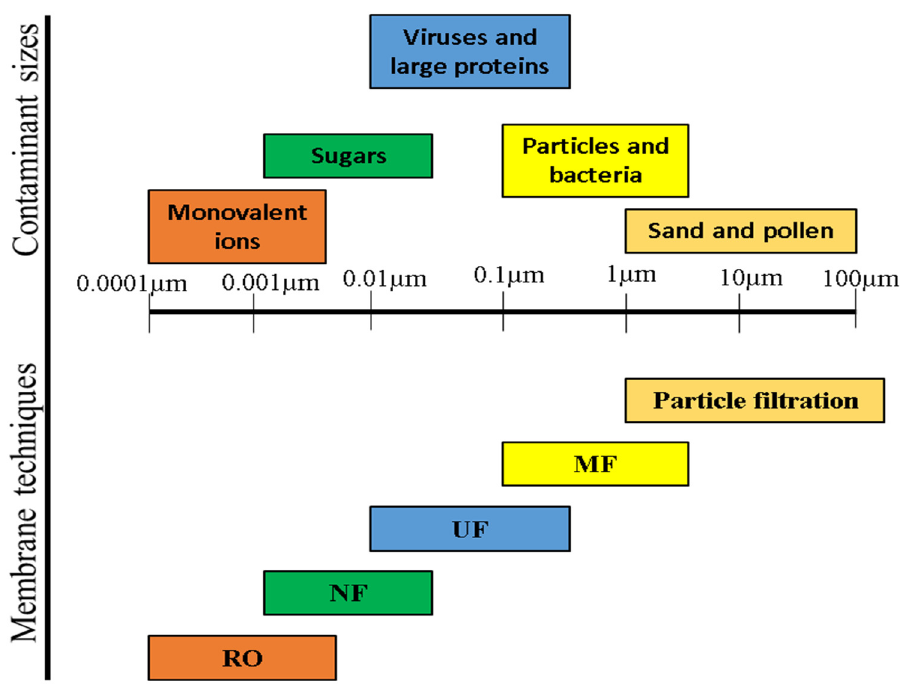
Figure 7. Common membrane-based processes for the removal of contaminants of various sizes from water and wastewater (adapted and modified from Anis et al. [100]).